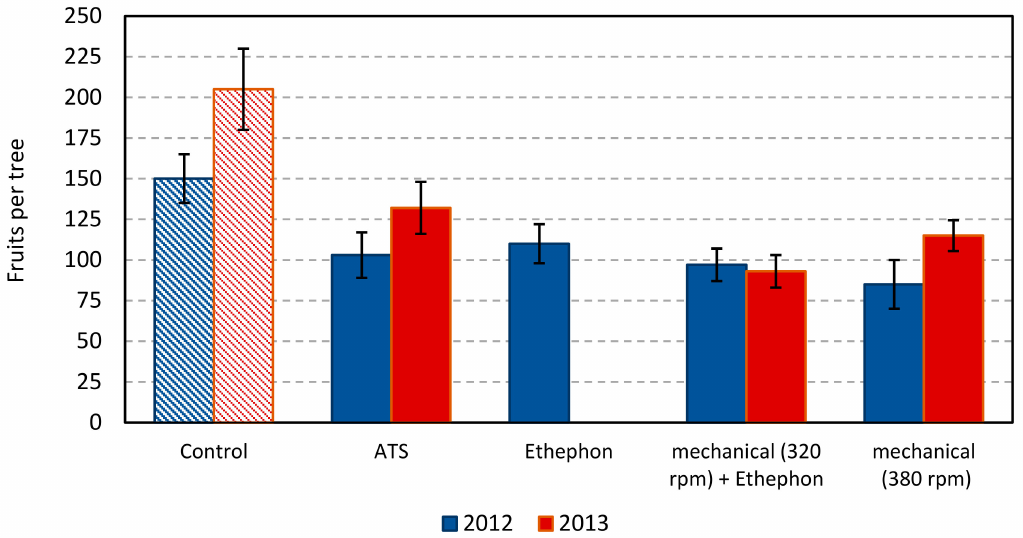
Figure 4. E ff ect of crop load management (CLM) on yield of the European plum cv. “Ortenauer” in Bonn, Germany, in 2012 and 2013; number of fruit per tree; error bars represent SDs at the 5% error